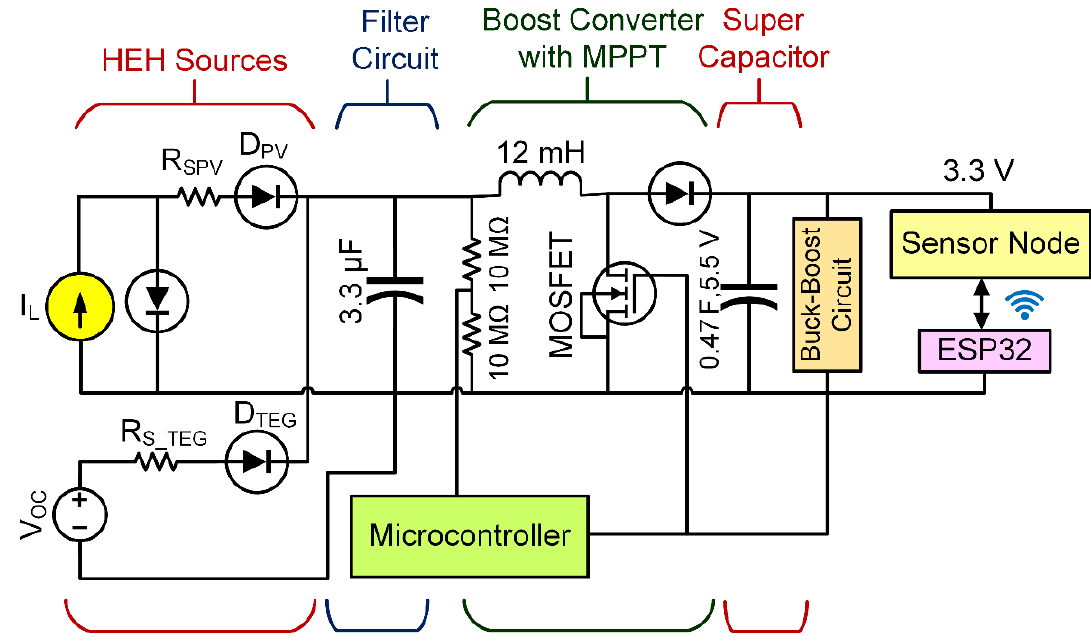
Figure 4. Simulink functional model of the proposed HEHS.